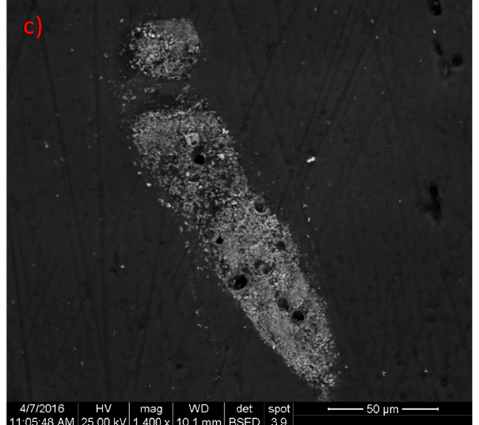
Figure 15. BSE images of crystals with anhedral ( a , b ) or subhedral ( c ) habitus (DMS_11M green/yellow natron-based tessera, Apollonia-type glass, from the Great Mosque of Damascus, Syria—unpublished data [24,25]).